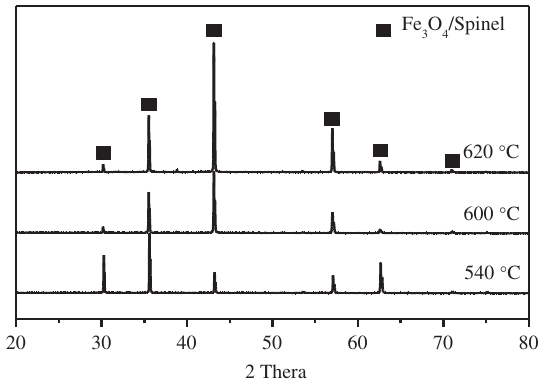
Figure 5: XRD patterns of samples exposed to SCW for 1000